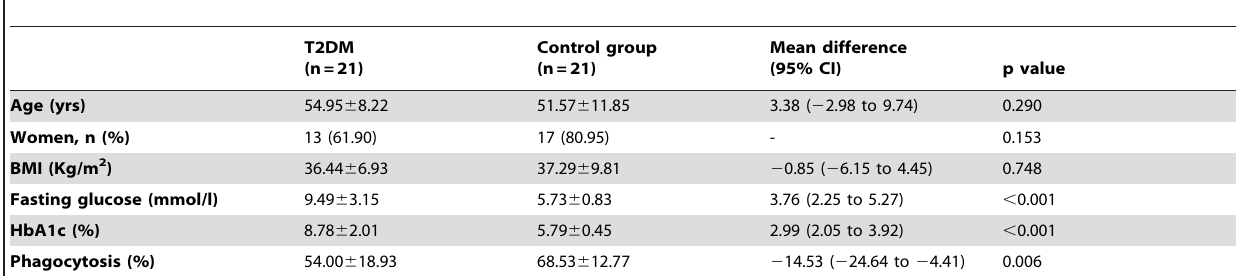
Table 1. Main clinical characteristics and metabolic data of participants included in the case-control study according to the presence of type 2